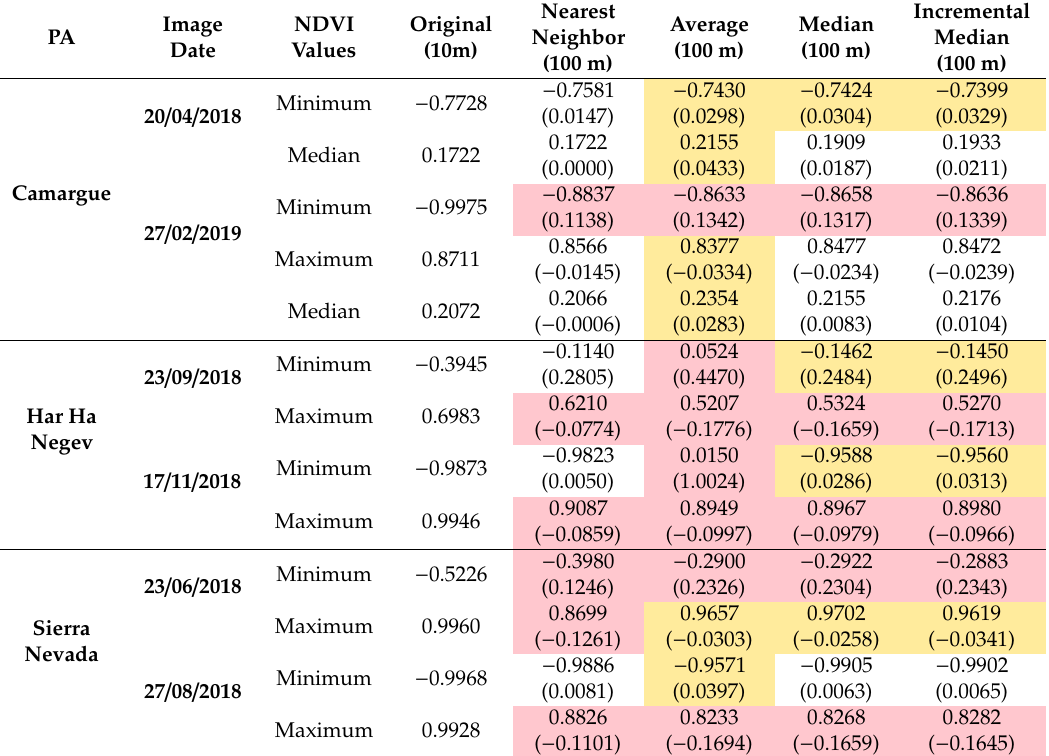
Table 8. NDVI values computed using two scenes per PA at the original 10 m and 100 m resolutions using several resampling methods. The values in parenthesis represent the variation of these values compared to the original resolution. Absolute variations between 0.025 and 0.05 are highlighted with a yellow background and those higher than 0.05 are highlighted with a red